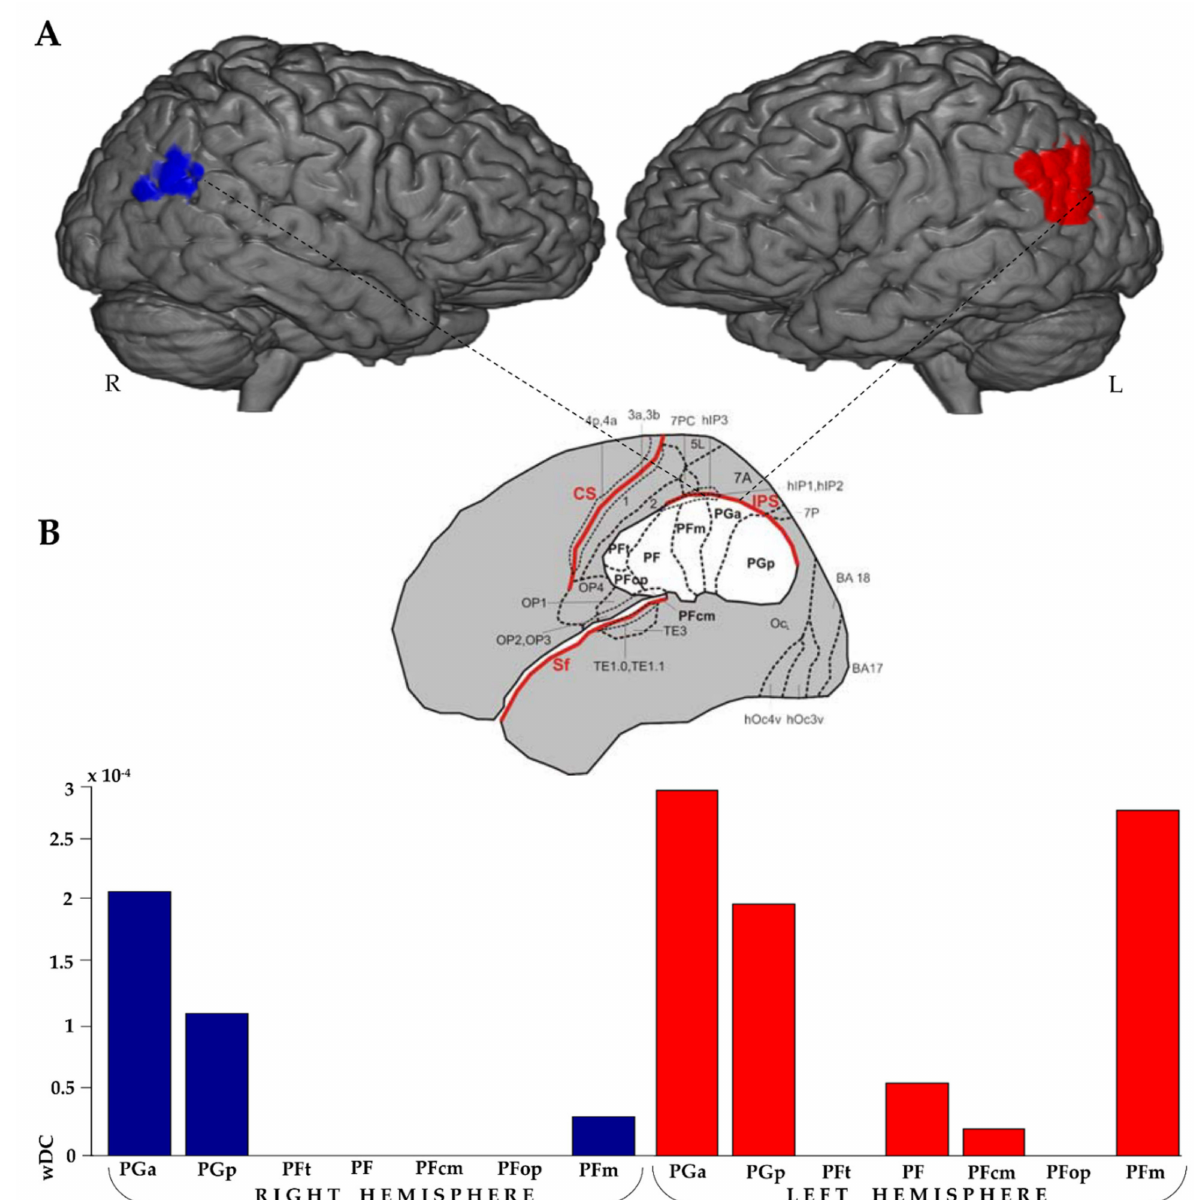
Figure 3. Overlap maps between FR > BC activation and IPL parcellation. Overlap pattern differences between brain hemispheres and within both left and right IPL are shown ( A ). Spatial similarity indices extracted with the wDC analysis for FR > BC contrast activation and IPL parcellation ( B